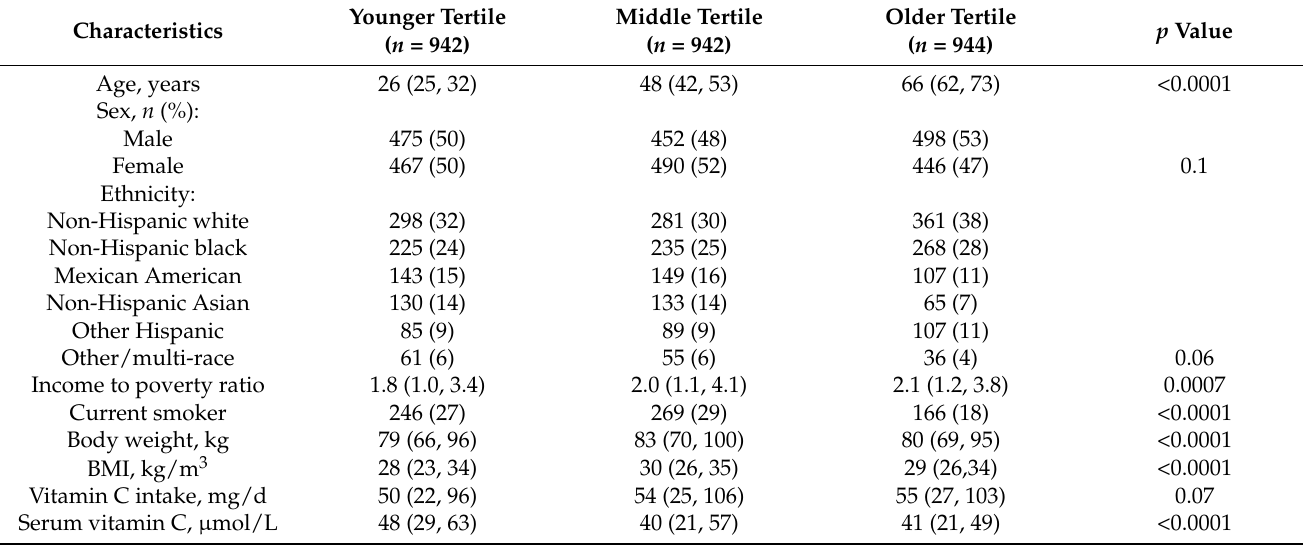
Table 5. Cohort characteristics stratified by